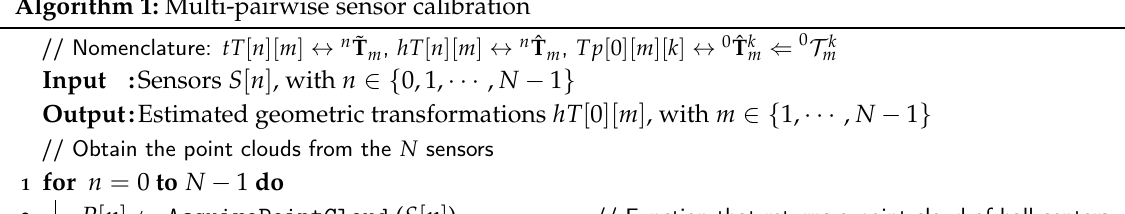
Algorithm 1: Multi-pairwise sensor